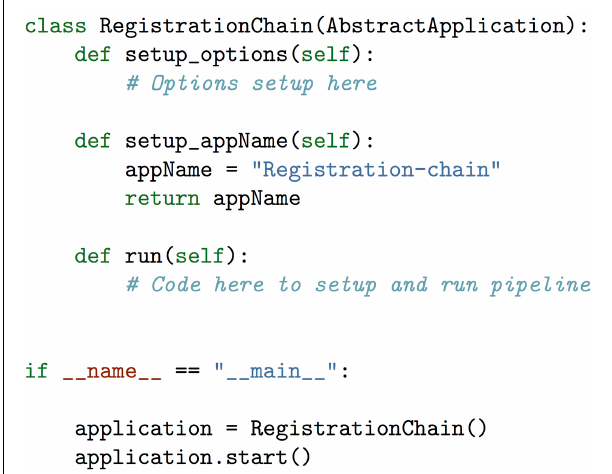
FIGURE 6 | Example of Pydpiper application code. Along with the required import statements (omitted from this figure for brevity), the .py file necessary to create an executable for a given application is extremely simple. This example is for the RegistrationChain application described in section 4.3 and is representative of how to construct an application that inherits from AbstractApplication . There are three functions included in RegistrationChain : setup_options , setup_appName , and run . run is the function that calls a unique combination of Pydpiper atoms and modules to construct the appropriate pipeline and in spite of the complexity inherent in this type of registration, this function is less than 100 lines of code. At the end of the file the if __name__ = "__main__" clause is required so that this code can be executed directly from the command line. In section 5, we show a complete example, albeit for a different application, of these